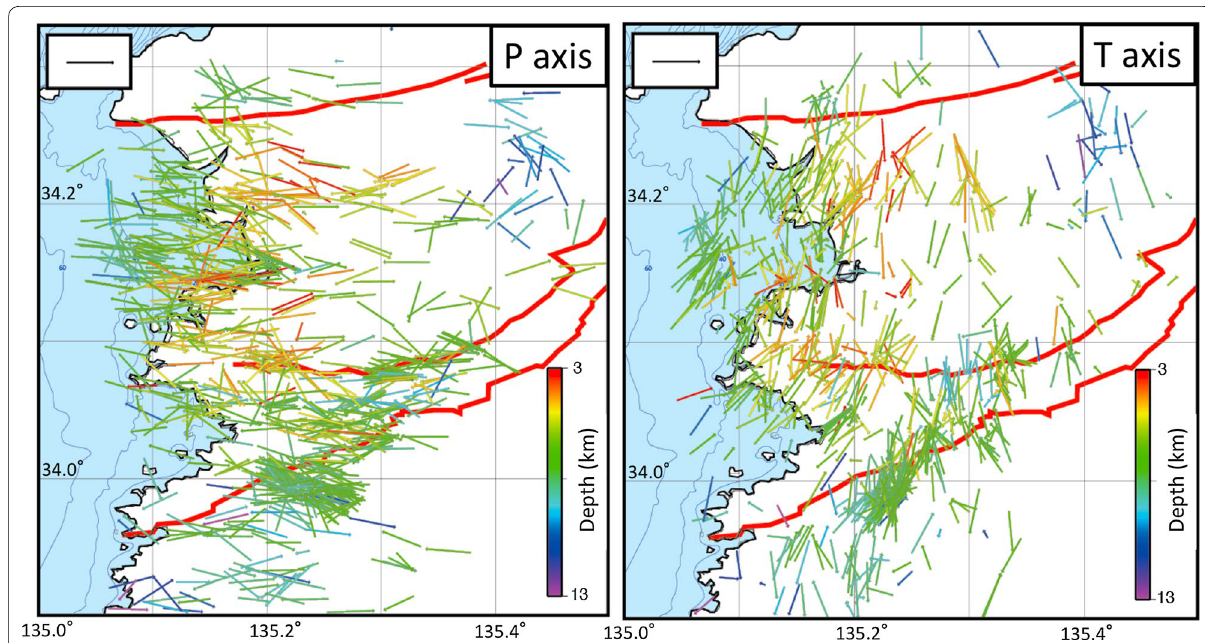
Fig. 7 P-axis (left) and T-axis (right) distributions. Starting point and color of each arrow show the epicenter and depth of the hypocenter deter- mined in this study, respectively. Principal axes are plotted using an orthographic projection, and the direction and length of each arrow represent the orientation and inclination of the axis, respectively. The upper left of each figure shows the scale when the inclination is 0°